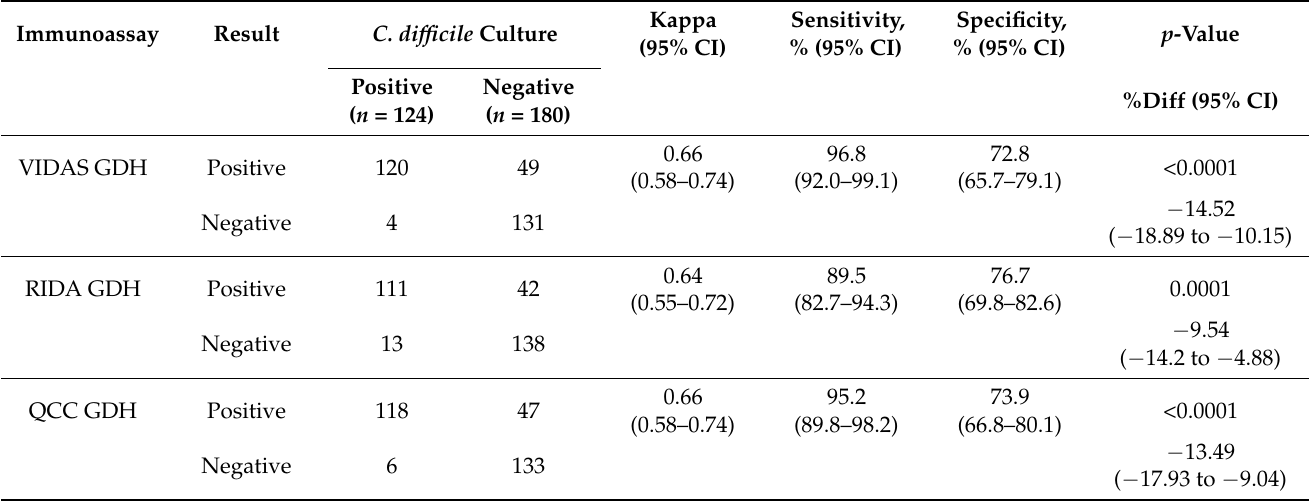
Table 2. Analytical performance results among the three immunoassays for the detection of Clostrid- ioides difficile glutamate dehydrogenase, as compared with Clostridioides difficile